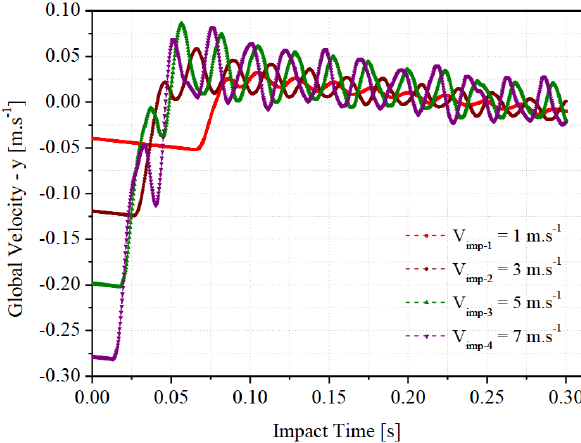
Figure 10: Global system velocity in impact: transverse direction